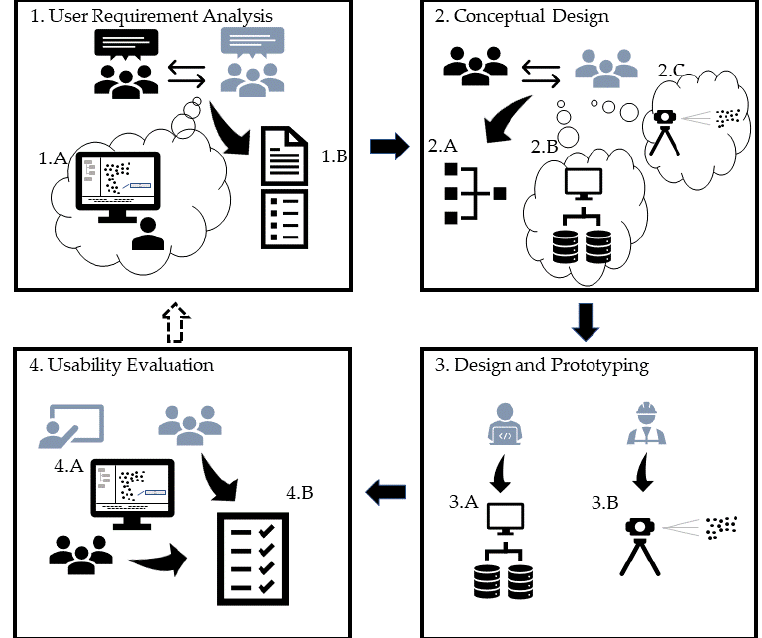
Figure 6. The four steps of the user ‐ centred approach and their main deliverables: 1.A—user